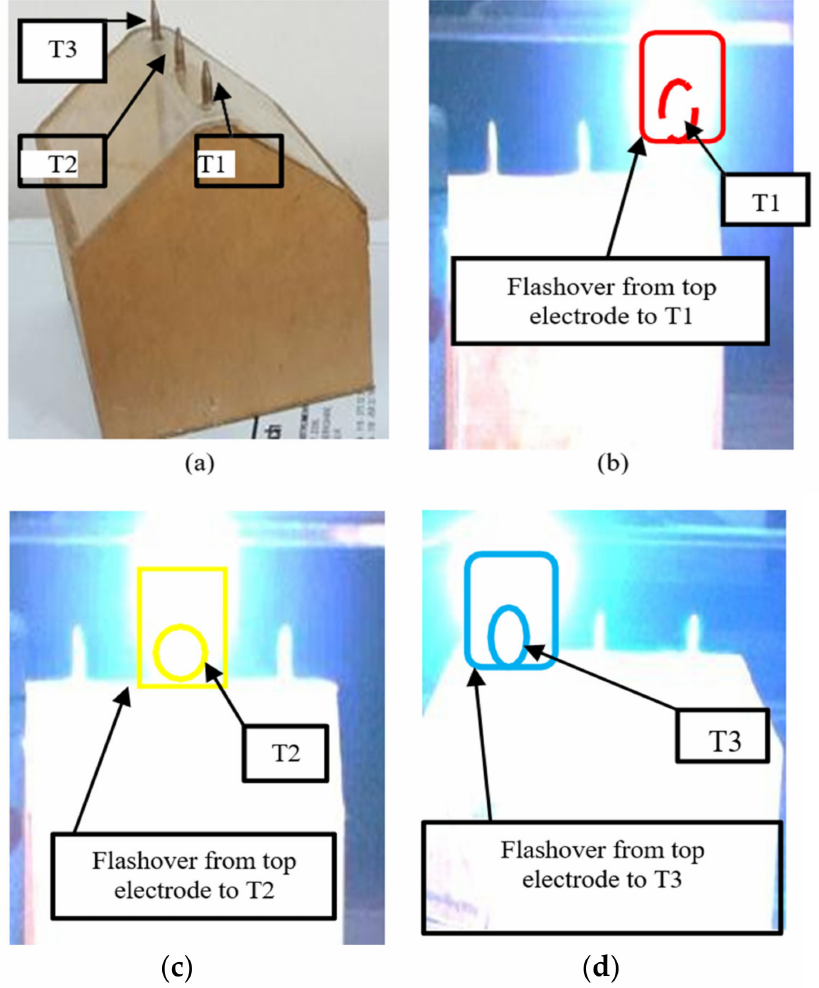
Figure 4. Lightning strike distribution on the Gable scaled model: ( a ) scaled gable shape ( b ) strike on LAT1, ( c ) strike on LAT2, ( d ) strike on